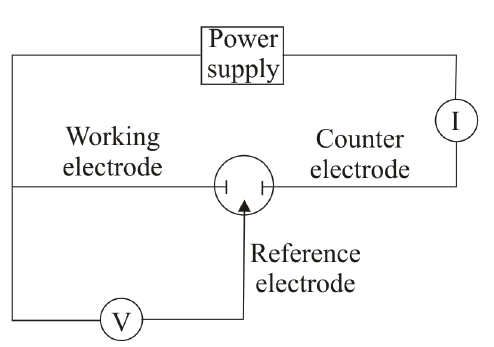
Figure 12. Schematic representation of the experimental